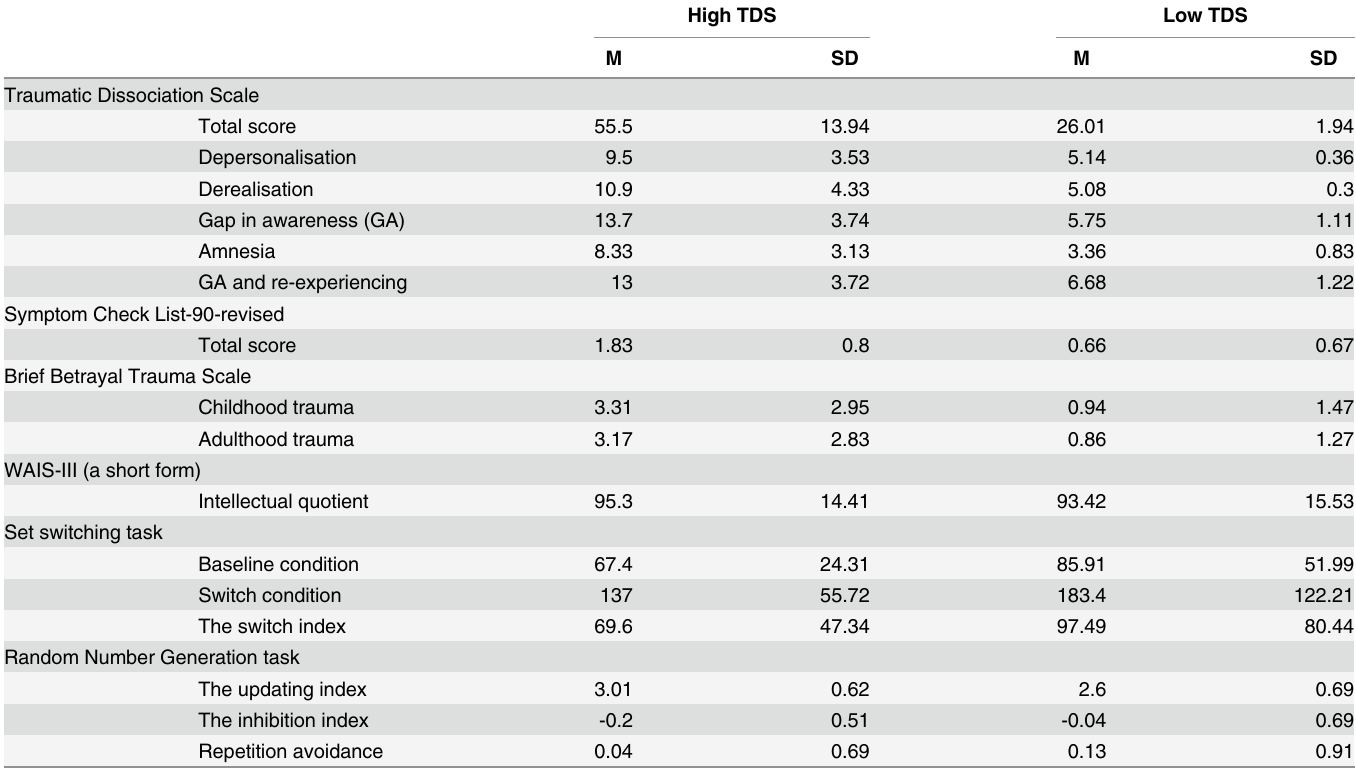
Table 1. Descriptive statistics of the behavioural and self-report measures between inpatients with high and low pathological dissociation.